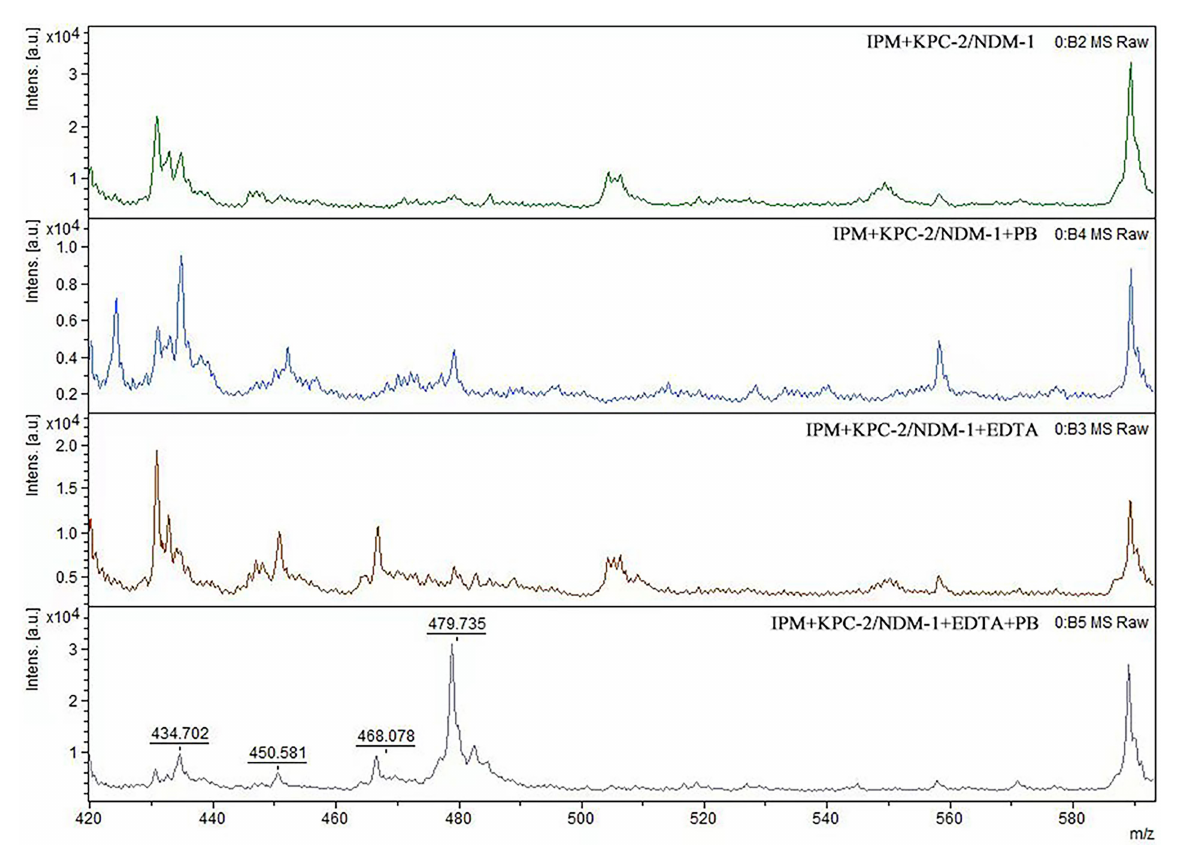
FIGURE 3 Mass spectra of the IPM hydrolysis analysis assay with dual-enzyme producing CPE. When EDTA and PB were added to MBL-and serine carbapenemase-producing strains, the 479 m/z mass spectrum peak reappeared.